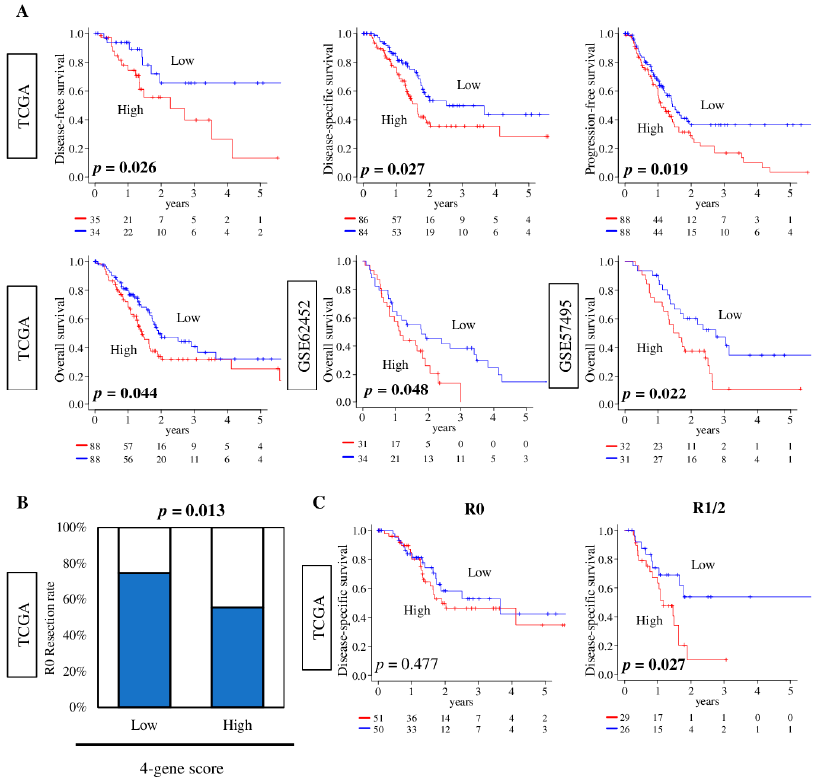
Figure 7. The association of the four-gene score with survival of pancreatic cancer patients and resection status. ( A ) Kaplan–Meier survival plots of comparison between low (blue line) and high (red line) four-gene score groups for disease-free survival (DFS), disease-specific survival (DSS), and progression-free survival (PFS) in the TCGA cohort, and overall survival (OS) in the TCGA, GSE62452, and GSE57495 cohorts. A log–rank test was used to calculate the p values. ( B ) Bar plot of achievement rate of R0 resection (blue) between low and high four-gene scores in the TCGA cohort. Fisher’s exact test was used to calculate the p value. ( C ) Kaplan–Meier survival plots of comparison between low- and high-four-gene-score groups, in an R0 or R1 / 2 resection, for DSS in the TCGA cohort. A log–rank test was used to calculate the p